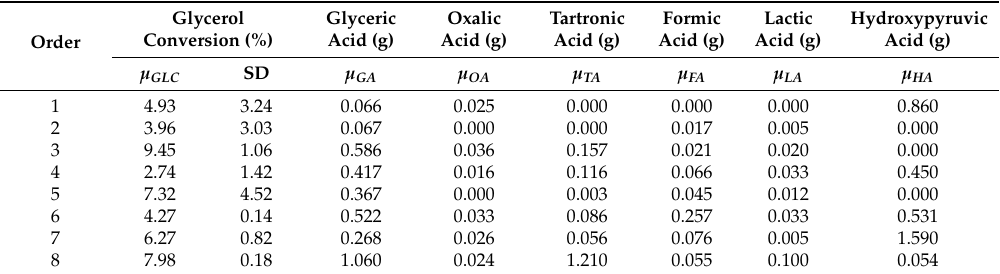
Table 5. Glycerol conversion and amount of oxidative products formed for the 60-min as-deposited electroless CuNiMoP/Al 2 O 3 catalyzed